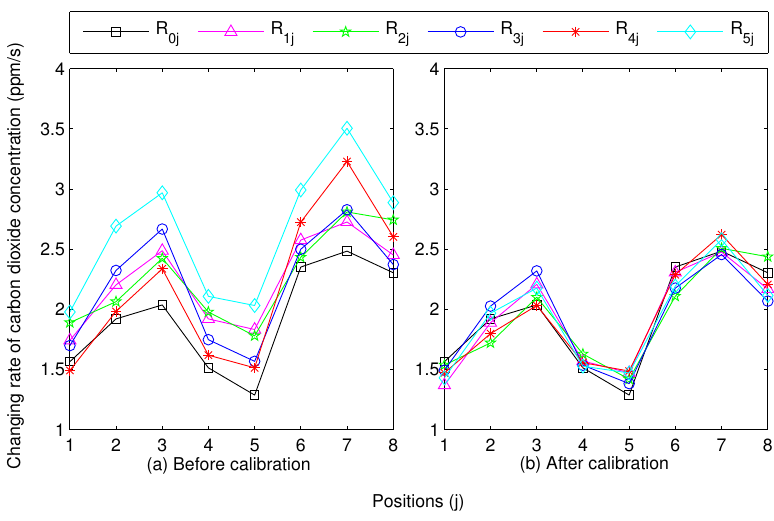
Figure 7. Changing rates of carbon dioxide concentration using 5 SCFSen nodes and a reference in 8 different positions.